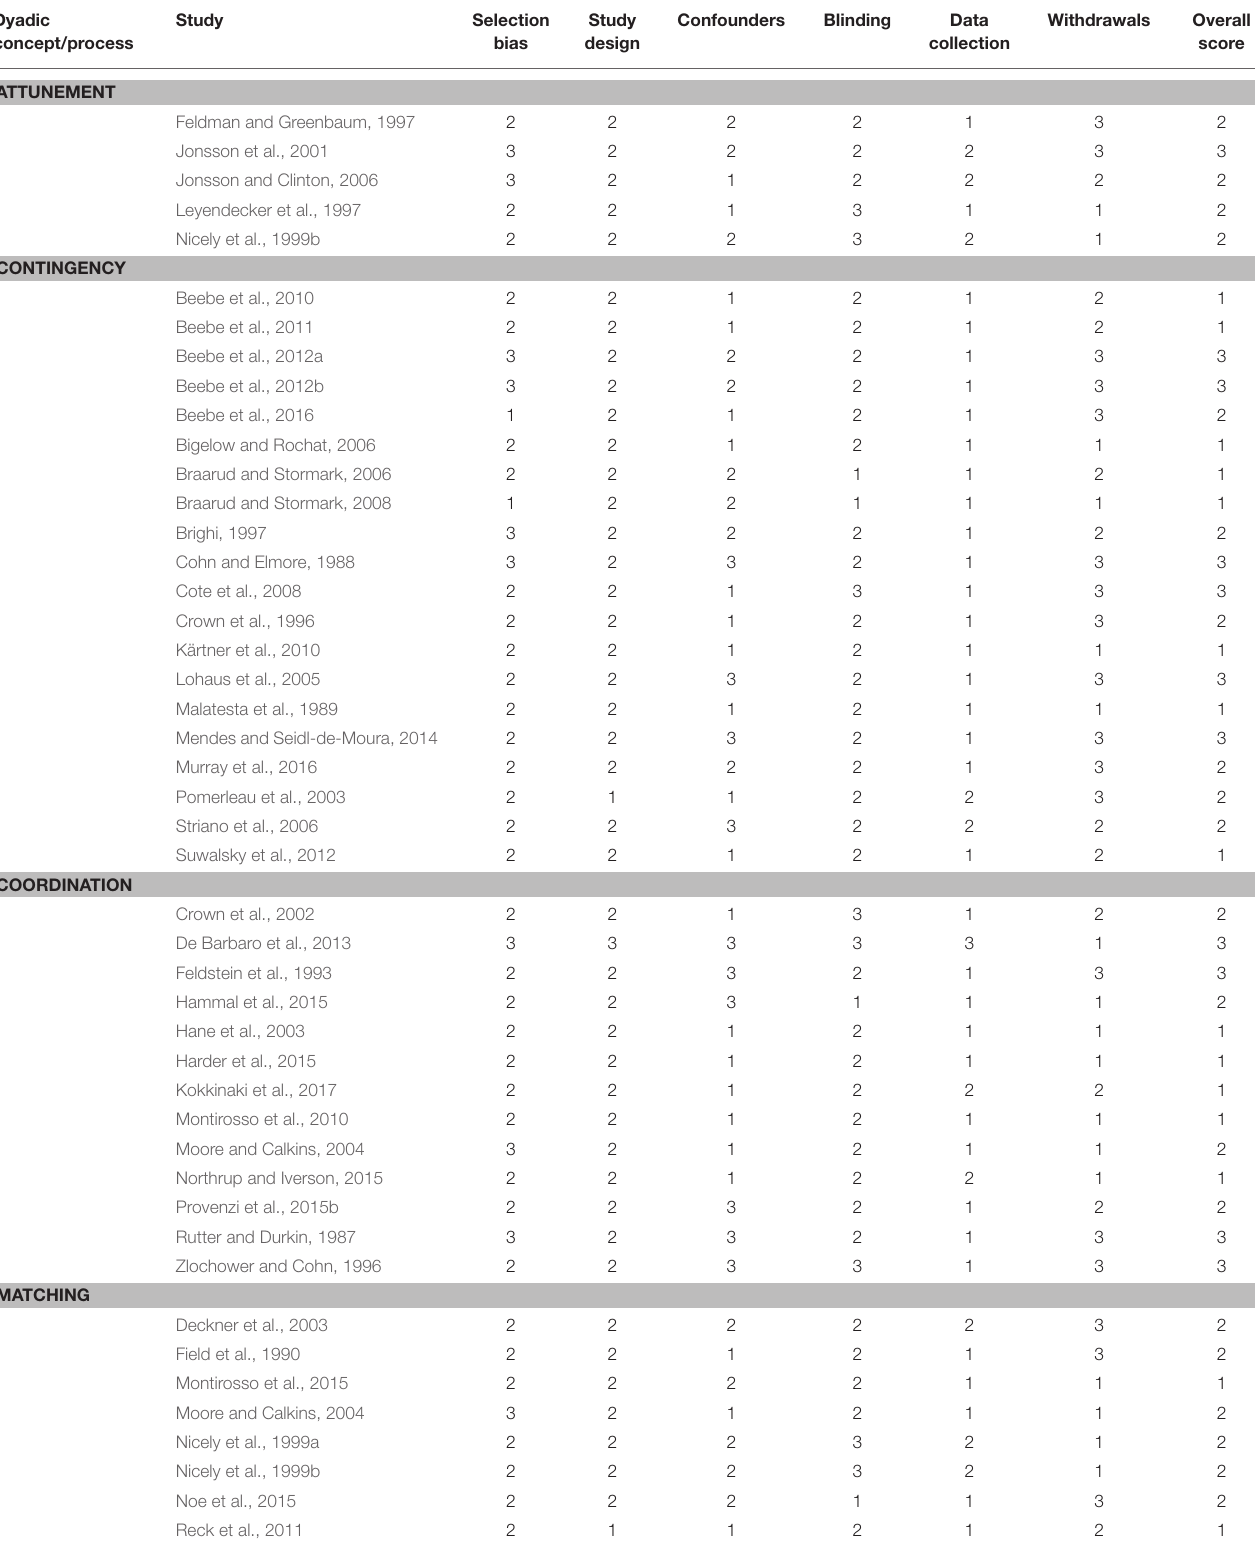
TABLE 2 | Quality appraisal for the included